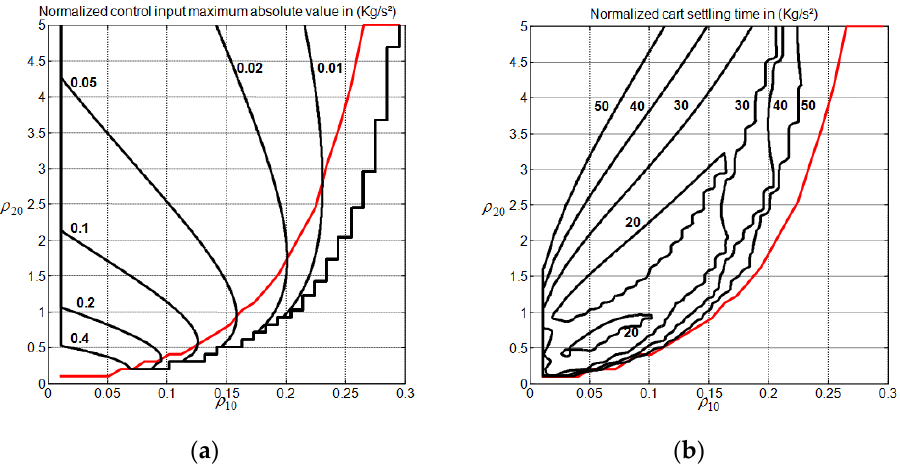
Figure 7. CIP control performance for GM min = 1.63. ( a ) Normalized control input maximum absolute value index; ( b ) normalized cart settling time index. Table 1. Transient response performance on the UR and LR frontiers.